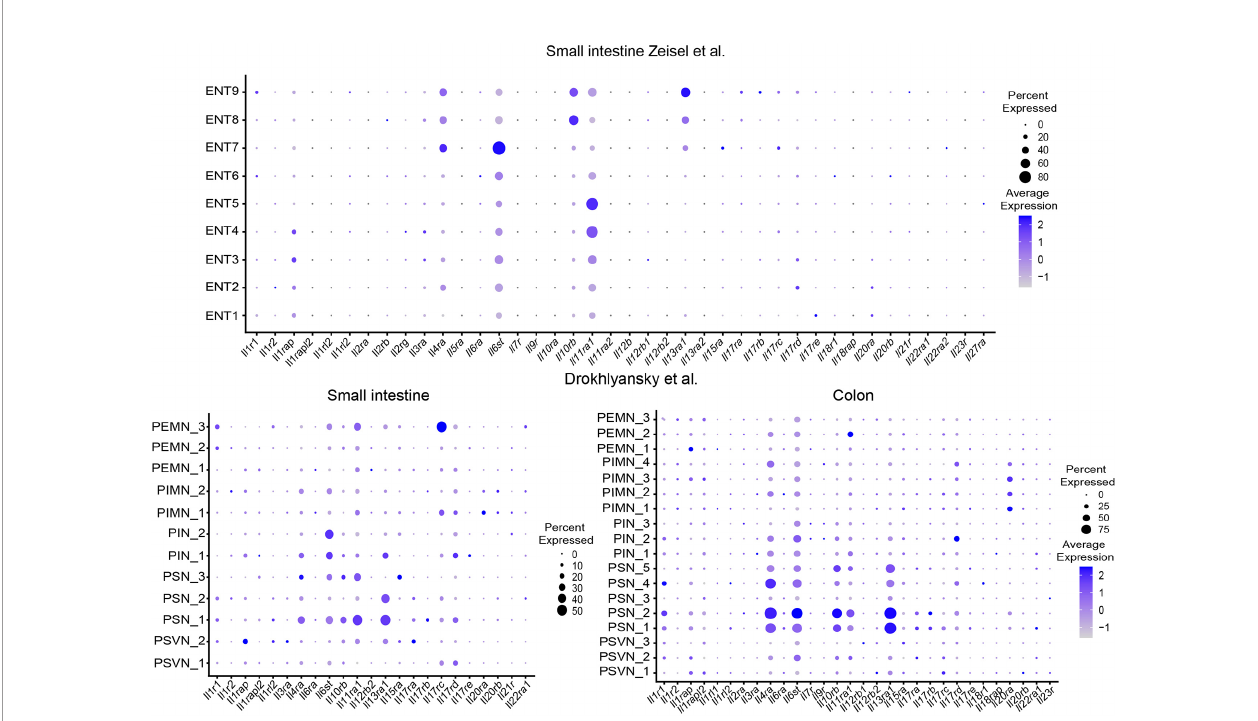
FIGURE 2 | Expression of interleukin receptors in different ENS subsets. Dotplots showing the percentage of expressing cells as well as average expression within the indicated identi fi ed neuronal clusters for selected murine interleukin receptor genes. Data was downloaded from http://mousebrain.org/ (12) or from https://singlecell.broadinstitute.org/ (14). Genes not present in the plot showing the Drokhlyansky data have been fi ltered. All dataset were normalized and transformed before the plots were created using the Seurat package